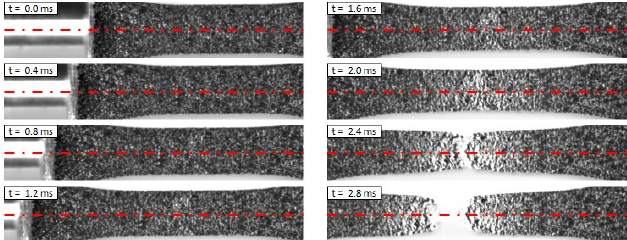
Fig. 7. High-speed photo sequence of OFE copper tested at 200 s -1